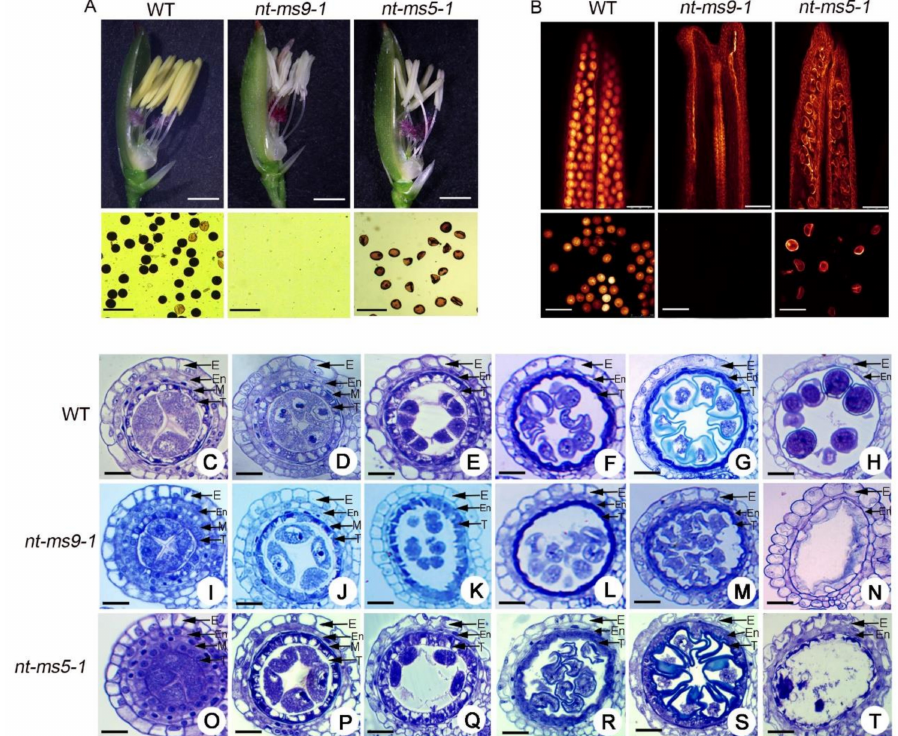
Figure 7. Phenotypic comparison and developing rice anthers between wild type (WT) and its two knock out lines ( nt-tms9-1 and nt-tms5-1 ) in H1. ( A ) Floral organs and pollen fertility between the wild type and its knock out lines after removal of the lemma. Bars = 1 mm. ( B ) Anthers and mature pollen grains between the wild type and its knock out lines using WE-CLSM analysis. Bars = 100 µ m. C to H Semi-thin sections of wild type anthers. ( C ) pre-meiotic interphase; ( D ) meiosis stage I; ( E ) meiosis stage II; ( F ) single microspore stage; ( G ) bicellular stage; ( H ) mature pollen stage. I to N Semi-thin sections of nt-tms9-1 anthers. ( I ) pre-meiotic interphase; ( J ) meiosis stage I; ( K ) meiosis stage II; ( L ) single microspore stage; ( M ) late bicellular stage; ( N ) mature pollen stage. O to T Semi-thin sections of nt-tms5-1 anthers. ( O ) pre-meiotic interphase; ( P ) meiosis stage I; ( Q ) meiosis stage II; ( R ) single microspore stage; ( S ) late bicellular stage; ( T ) mature pollen stage. E, En, M and T indicate the epidermis, endothecium, middle layer, and tapetum, respectively. Bars = 50 µ